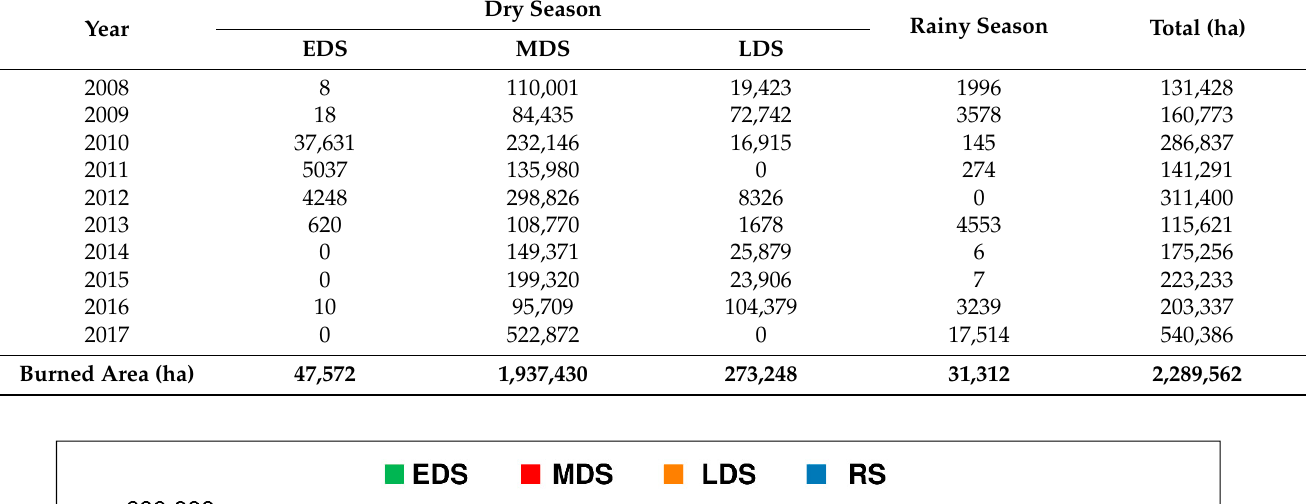
Table 4. Area burned in hectares (ha) categorized by climatic season.